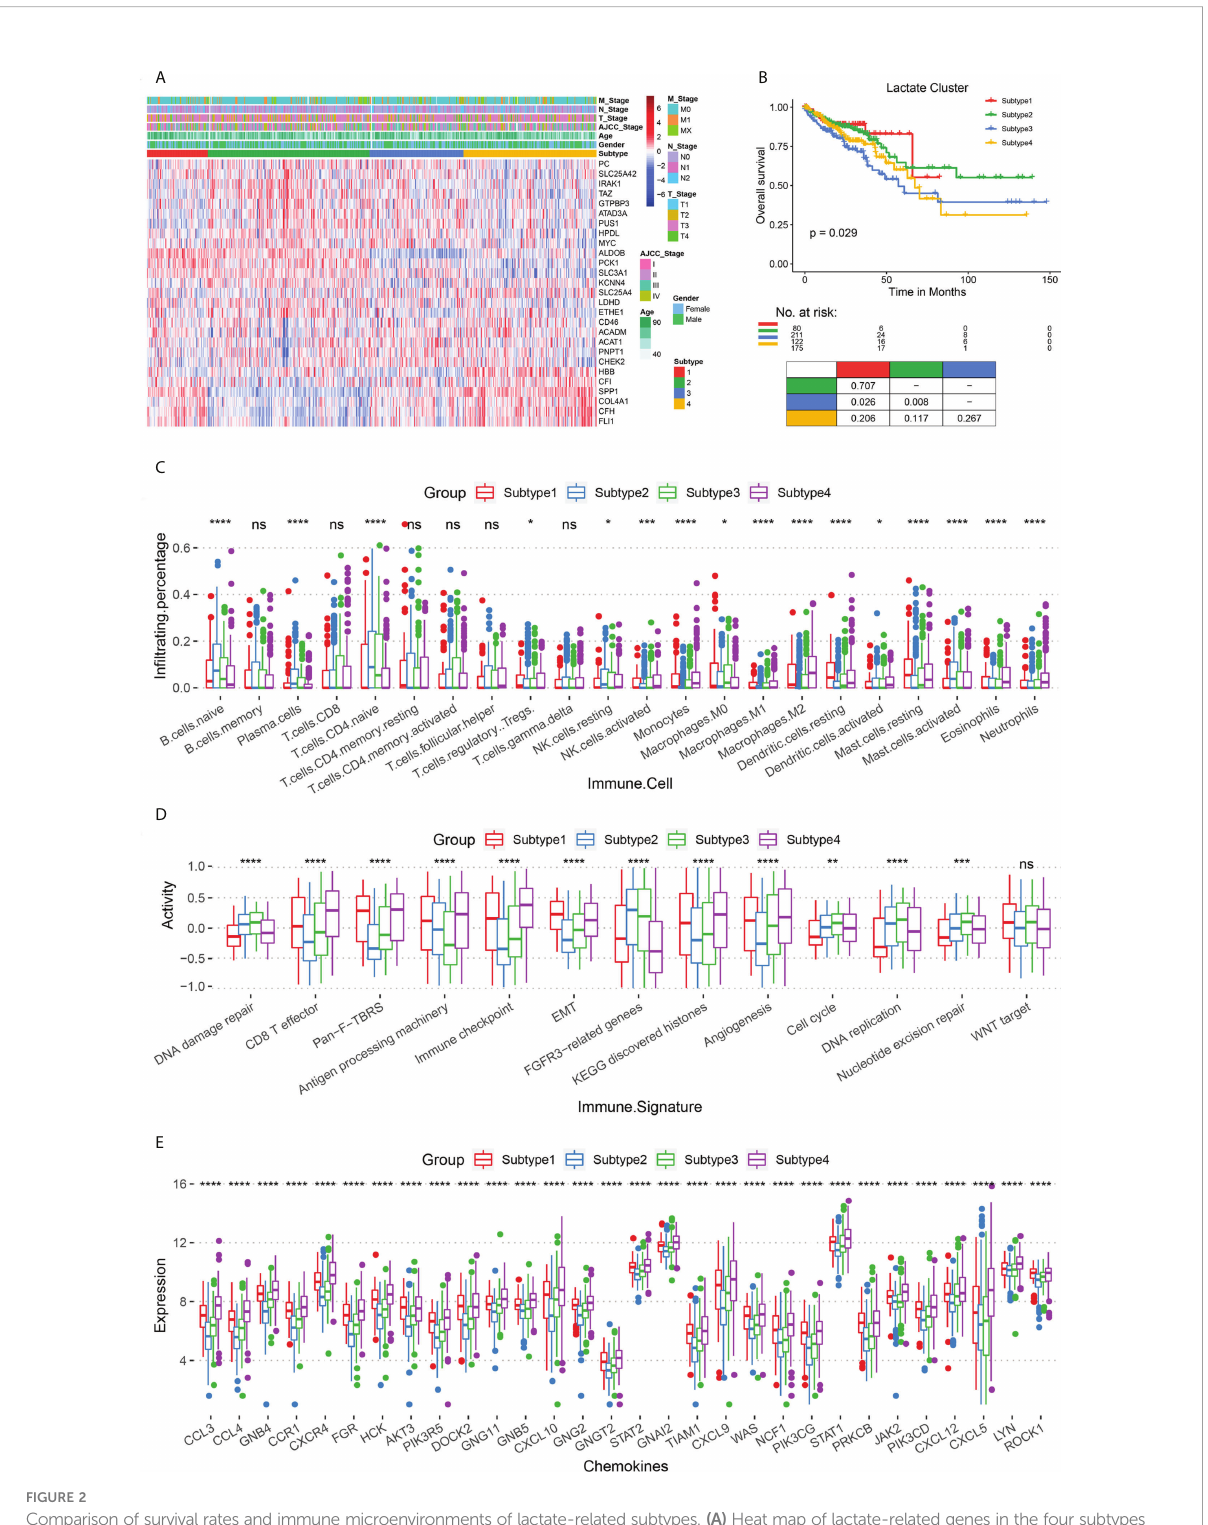
FIGURE 2 Comparison of survival rates and immune microenvironments of lactate-related subtypes. (A) Heat map of lactate-related genes in the four subtypes (subtypes 1 - 4), along with age, sex, AJCC tumor stage, and TNM stage. (B) The OS analysis among lactate subtypes; P values derived from a log-rank test. Pairwise comparison is shown at the bottom. (C) Box plot for comparing the in fi ltration percentage of 22 immune cells; immune cell in fi ltration has been evaluated by CIBERSORT. (D) Box plot for comparing the immune signatures, as calculated by GSVA. (E) Box plot for comparing the expression of chemokines. In (C – E) , * P < 0.05; ** P < 0.01; *** P < 0.001; **** P < 0.0001; ns, not signi fi cant (Kruskal-Wallis